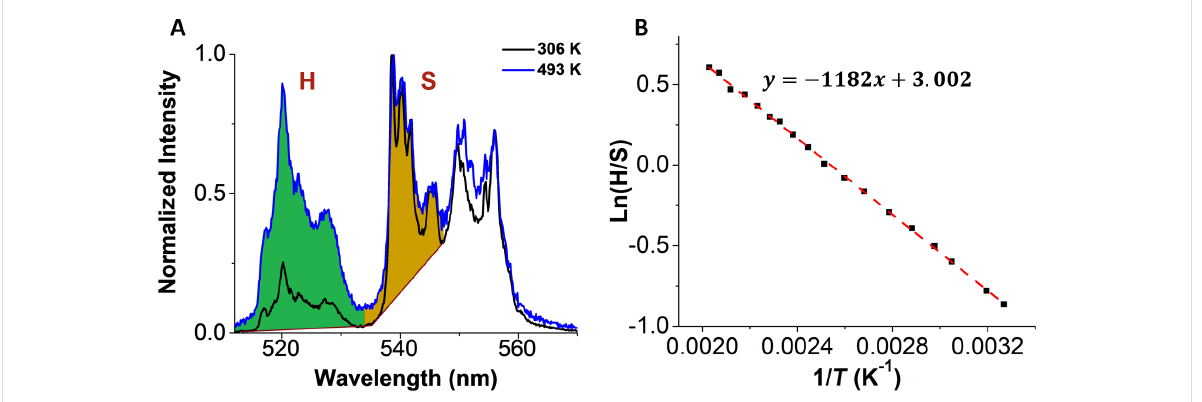
Figure 2: (A) Upconversion emission spectra of UCNPs at different temperatures. A temperature-dependent green emission is measured for a tem- perature range of 306–493 K. (B) A plot of ln(H/S) vs 1/ T for calibration of UCNPs. The H- (514–534 nm) and S- (536–548 nm) band area selected for the calibration are shaded in green and brown, respectively, in (A). The slope of the line calculated is − 1182 ± 8 K and the intercept is 3.002 ± 0.021.